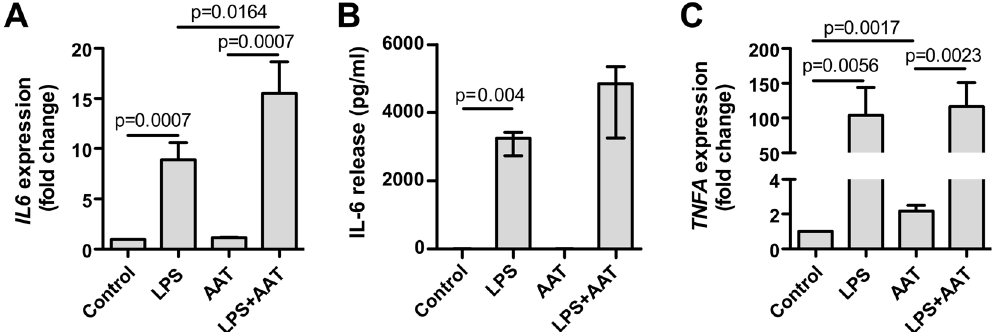
Figure 10. Effects of AAT, LPS or their combination on IL-6 and TNF α in H1975 cells. Cells were cultured for 18 h in the medium containing HBSS (controls), 10 µ g/ml LPS or 1.5 mg/ml AAT separately and in combination. ( A ) IL6 gene expression relative to housekeeping gene POLR2A and normalized to controls (fold change). Each bar represents mean (SD) of three independent experiments. ( B ) IL-6 release measured by ELISA. Each bar represents median (25–75 percentile) of eight independent experiments. ( C ) TNFA gene expression relative to housekeeping gene POLR2A and normalized to controls (fold change). Each bar represents mean (SD) of three independent experiments. p < 0.05 was considered as significant.